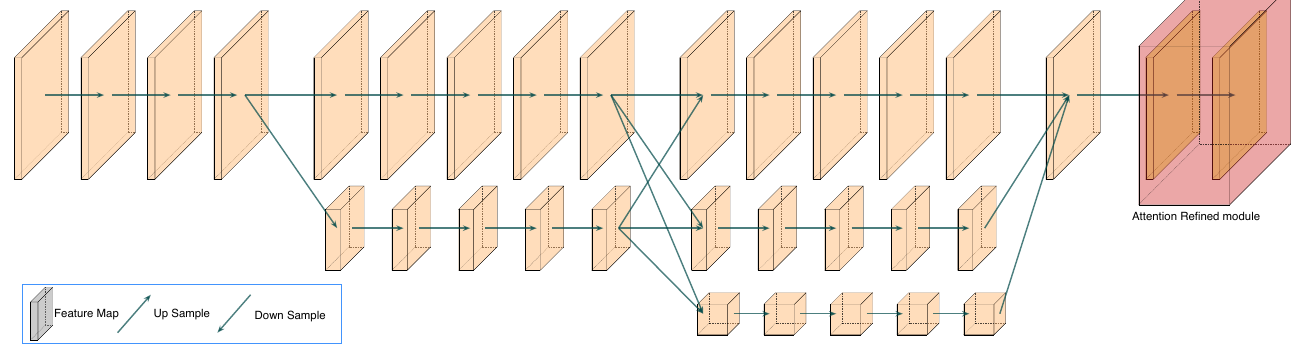
Figure 1. Illusion of the whole structure of our network.